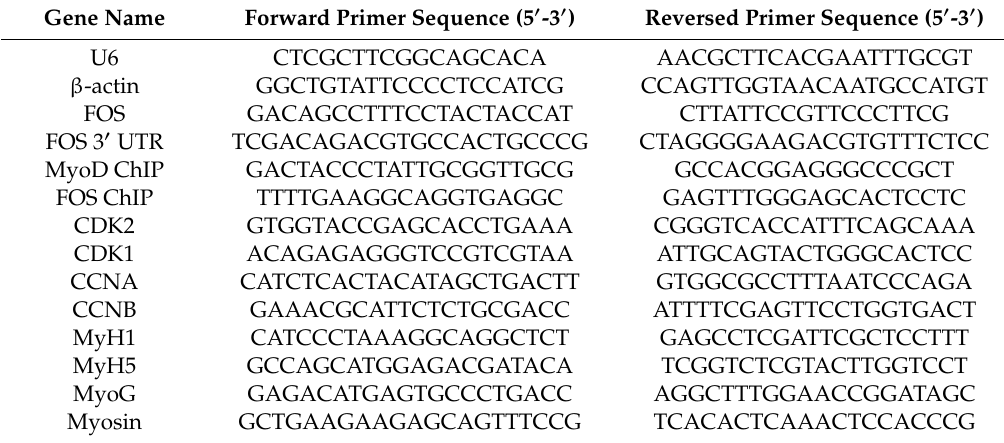
Table 1. All the primers used in this